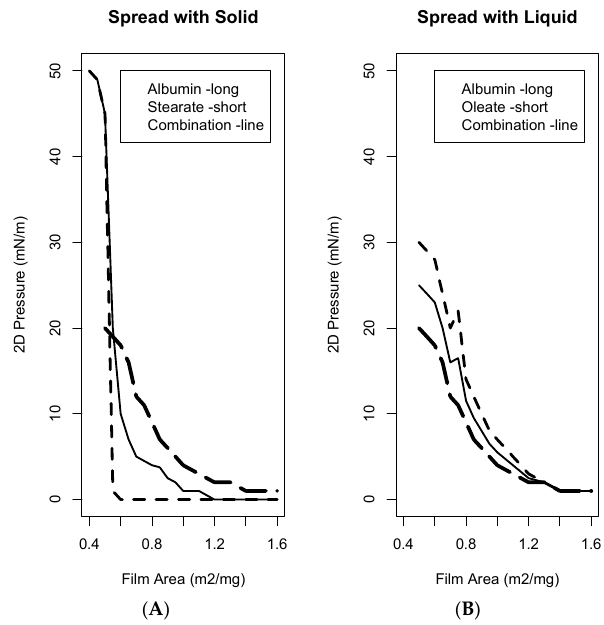
Figure A1. Comparison of film pressure versus area isotherms as calculated using the appendix (power Langmuir) equations of state for ( A ) the main proxy compounds along with a sample mixture containing 3% fatty acid, as judged by carbon atom solute concentration, and ( B ) oleic acid substituted for stearic acid. The potential for loss of 2D condensed behaviors is clear. “Long” and “short” refer to the dashed curves.